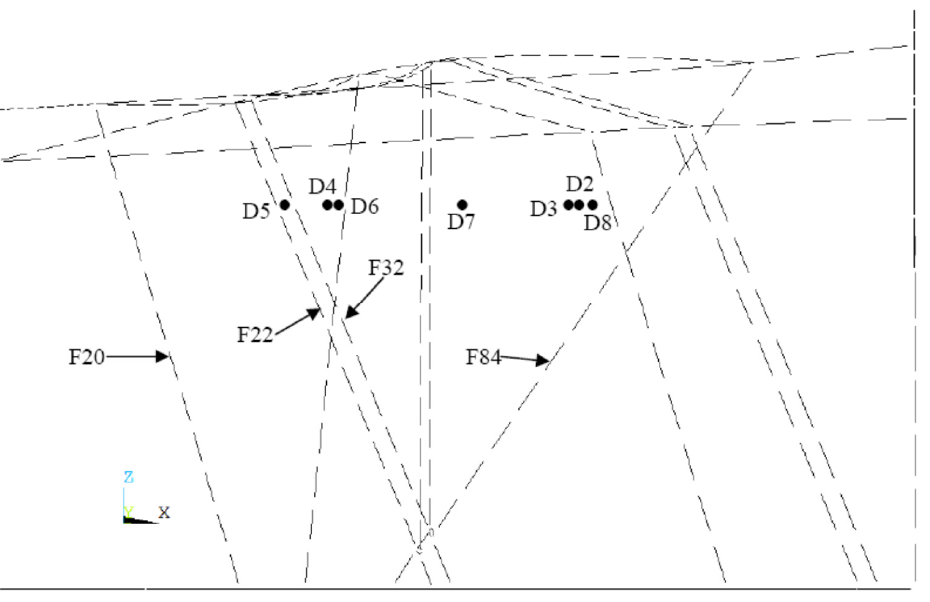
( b ) The projection view from the negative axis to the positive axis of Y